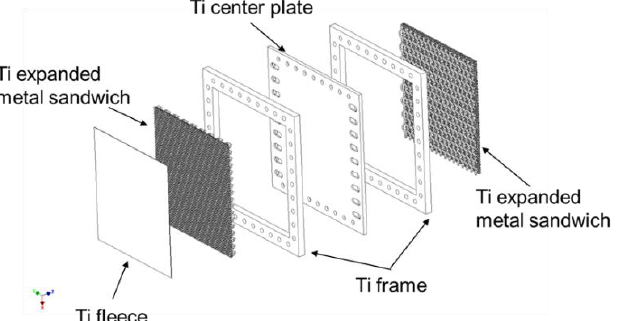
Figure 8. Exploded view of the bipolar plate unit comprising multiple parts from Energy Lab 2.0 and LLEC prior to the joining process. The active cell area of its basic quadratic design amounts to 1056 cm 2